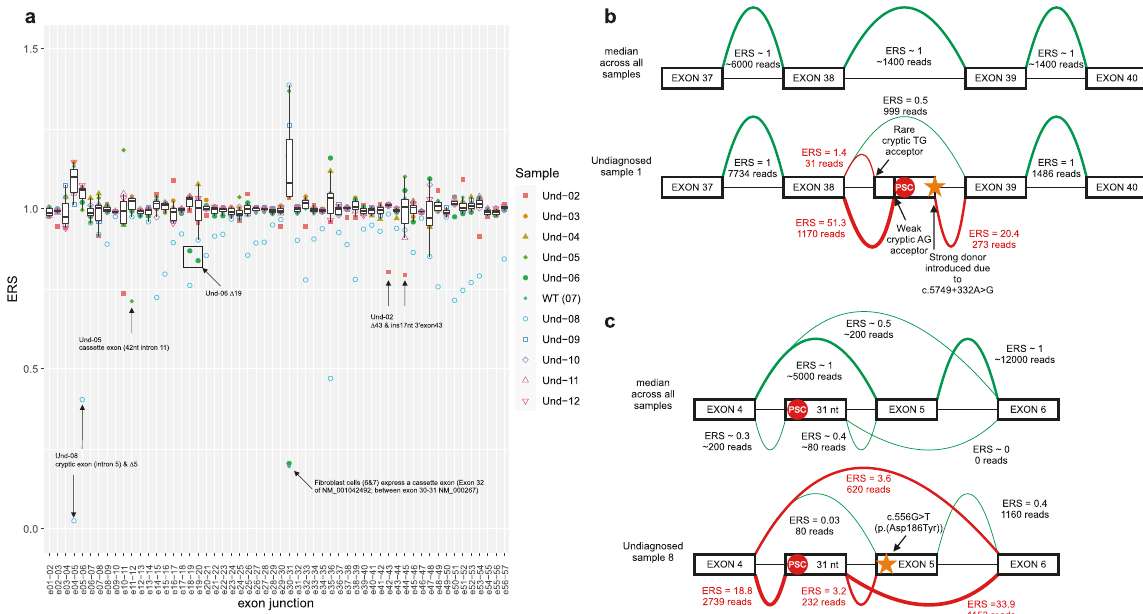
Fig. 2 For all patient derived samples with a pathogenic splicing event a concomitant drop of the normal exon junction in close proximity is visible. Enrichment score of normal exon-exon splice junctions of the undetermined cohort ( a ), annotated in the fi gure are the drop in ERS due to the detected pathogenic splicing event. Normal reference exon splice junctions are expected to have a median ERS ~1. center line of the boxplot represents the median value (Q2), bounds of box are Q1 and Q3 respectively and whiskers Q1 – 1.5xIQR and Q3 + 1.5xIQR respectively. Outliers are depicted with color and shape matching the speci fi c sample (see inner fi gure legend). Splicing of undetermined 1 and 8 explained ( b / c ). Shown are the median ERS and reads for all samples within the same run vs the actual ERS and reads of the sample indicated; undiagnosed 1 ( b ) and undiagnosed 8 ( c